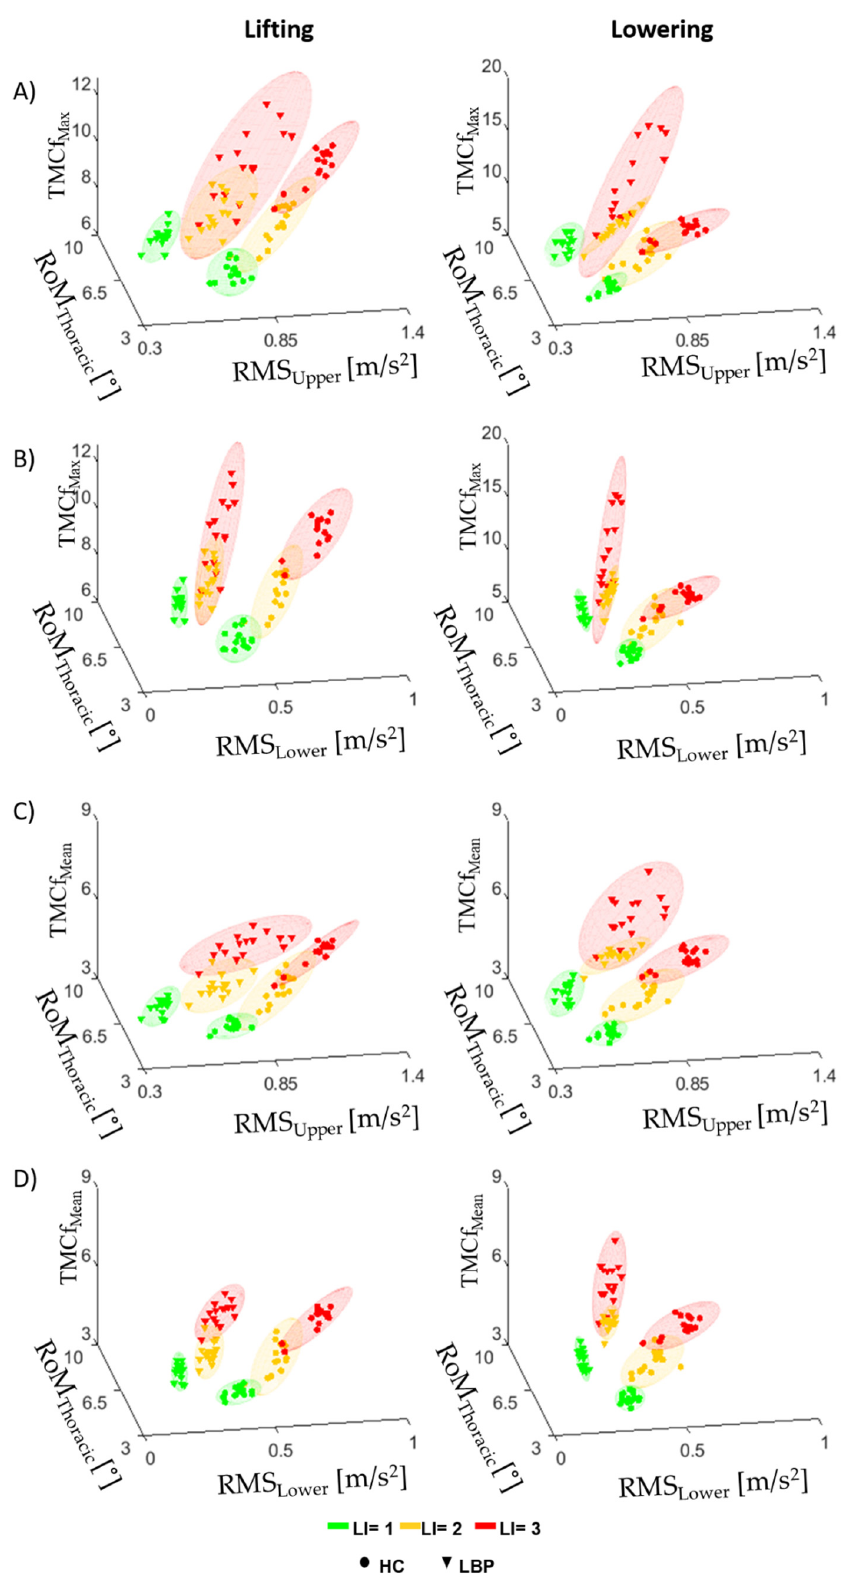
Figure 6. Plot 3D with mean for each risk level in both groups for the max (TMCf Max , ( A , B )) and mean (TMCf Mean , ( C , D )) values of TMCf function, the RoM of the flexion-extension of the Thoracic region (RoM Thoracic ) and the RMS of the acceleration of the upper (RMS upper , ( A , C )) and lower trunk (RMS lower , ( B , D )) considering all repetitions within each minute of lifting and lowering